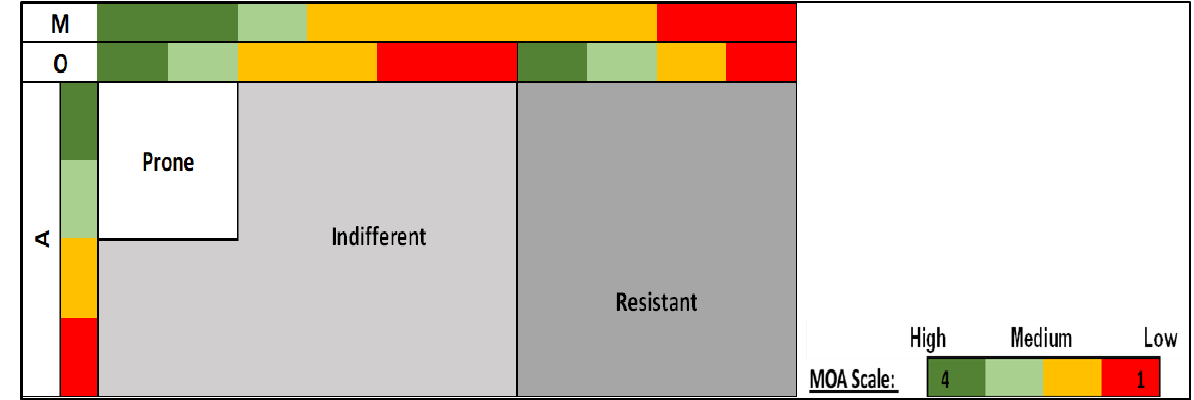
Figure 7. Identification of Energy-Use Profiles Matrix [7,20].